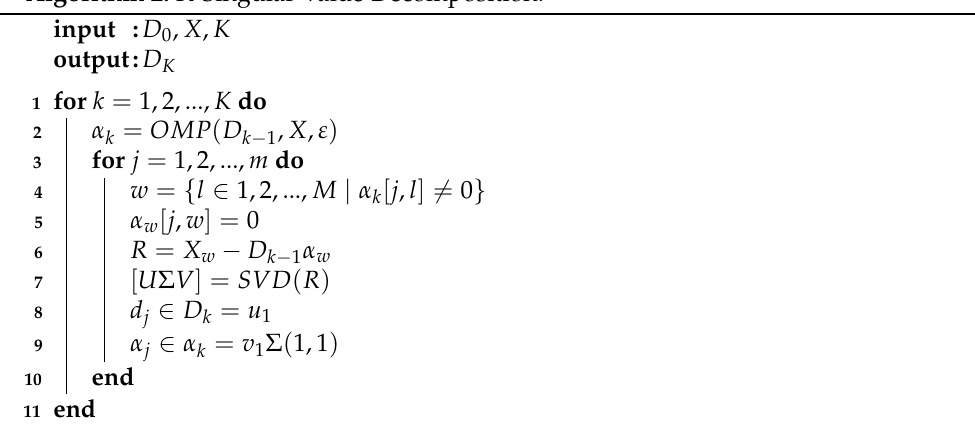
Algorithm 2: K-Singular Value